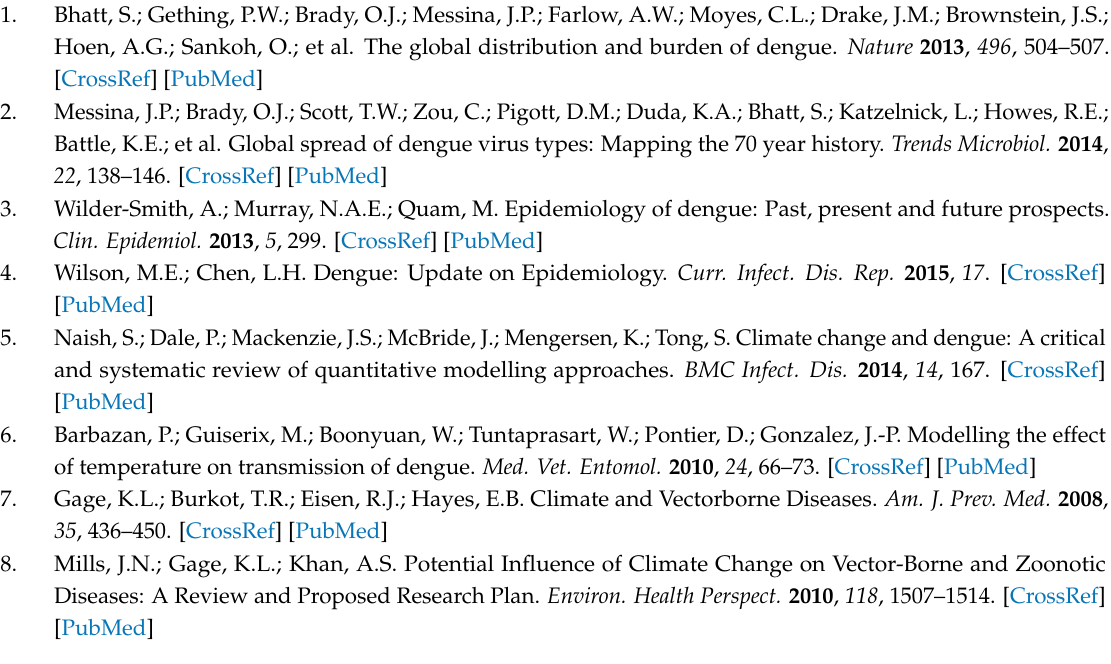
training gain; Figure S2: Response curves for climate variables related to the distribution of dengue fever; Figure S3: Distribution of Present Climate suitable pixel along the elevation gradient; Figure S4: Distribution of Future Climate suitable pixel in different concentration pathways along the elevation